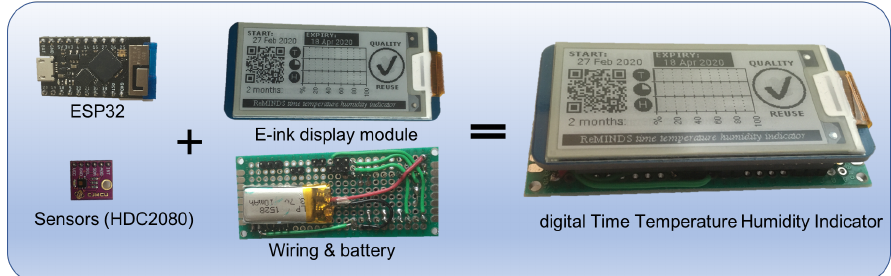
Figure 3. Hardware assembly of the dTTHI